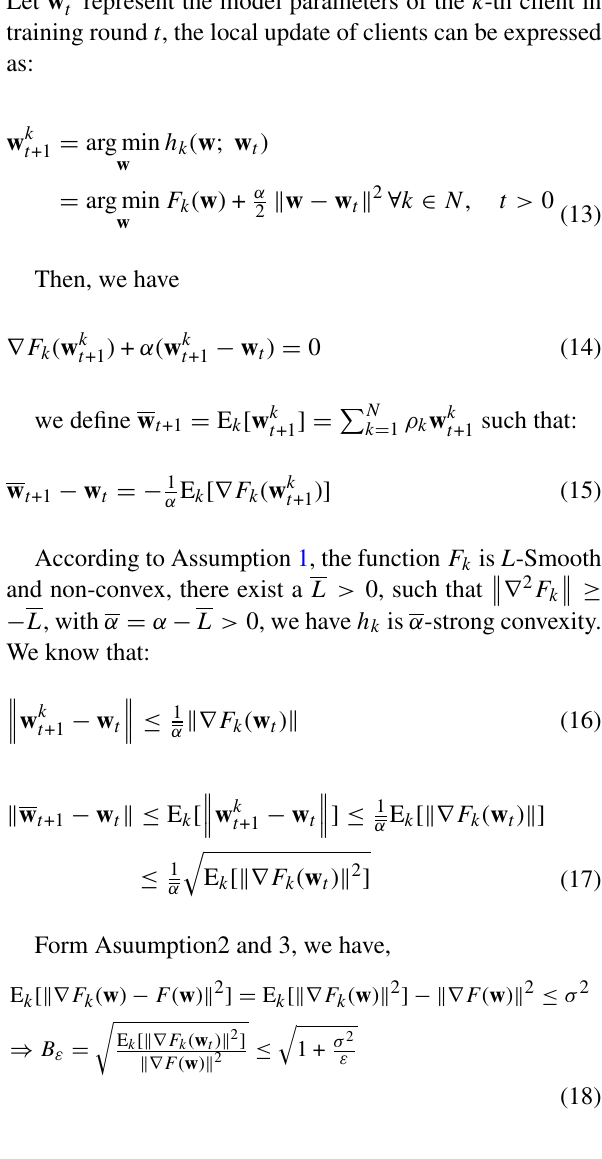
Table 2 Average validation performance over the last 50 rounds for MNIST and EMNIST-L, 500 rounds for Cifar-10 and Cifar-100; % accuracy; on non-IID2 split